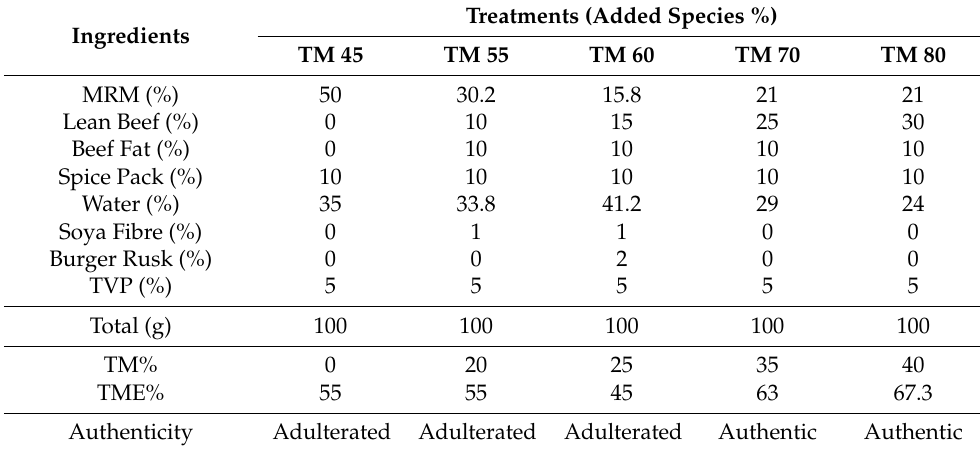
Table 4. Formulation of treatments for Patty 4 (econo burger/budget